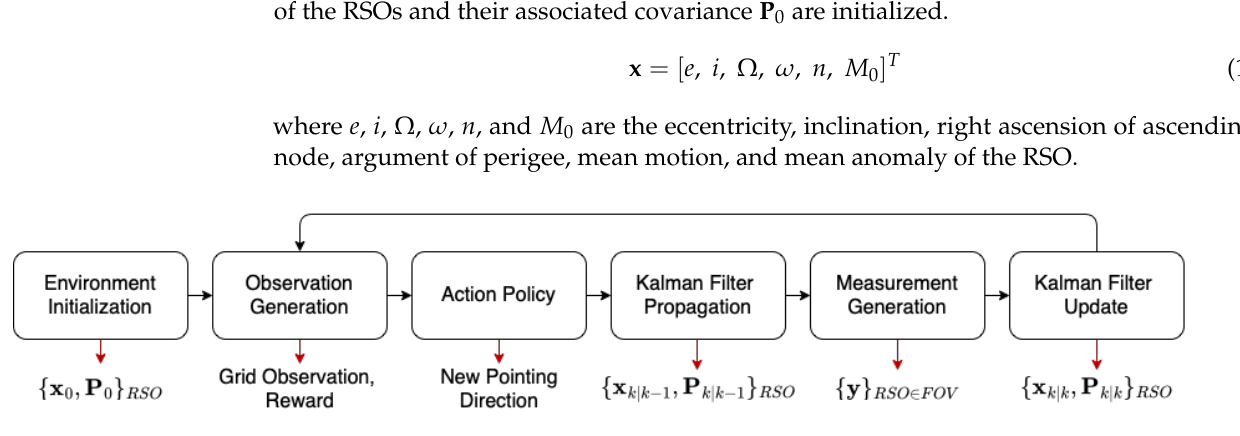
Figure 1. Process flow for the space situational awareness